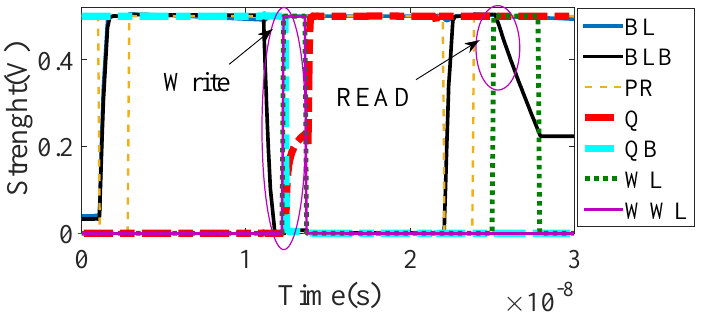
Figure 9. Read and write waveform and important signals for existing 12T SRAM cell at 0.5 V supply voltage.